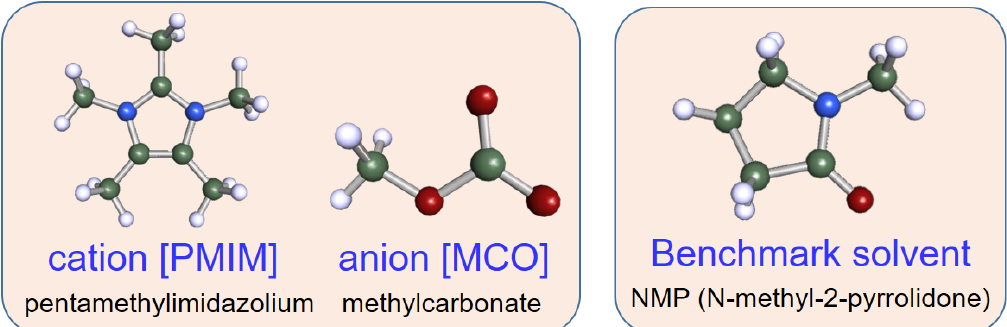
Figure 3. Structure information of the screened IL and the benchmark solvent